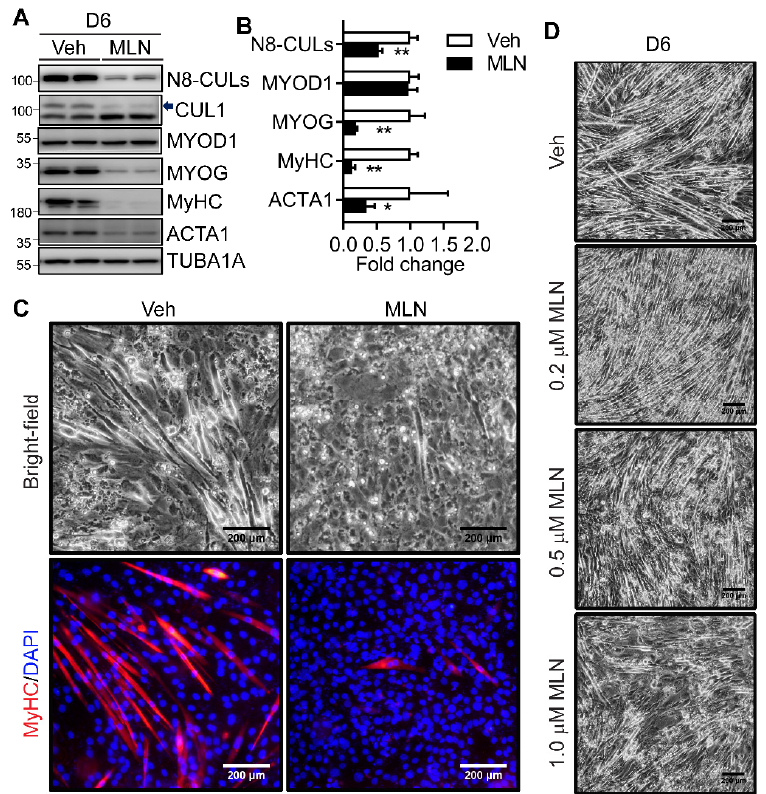
Figure 2. Neddylation inhibition mediated by a specific NAE1 inhibitor MLN4924 blocks C2C12 myotube formation. ( A , B ) Western blot analysis of neddylated Cullins (N8-CULs), CUL1, and muscle differentiation markers in vehicle (Veh)-treated and MLN4924 (MLN, 0.5 µ M)-treated C2C12 for 6 days (D6) in differentiation media. Proteins were quantified and normalized to TUBA1A. Arrow indicates neddylated CUL1. Data were presented as fold changes with Veh-treated cells set at 1. * p < 0.05; ** p < 0.005 vs. Veh. Unpaired t tests. ( C ) Representative bright-field and immunofluorescence images of Veh-treated and MLN-treated C2C12 at D6 of differentiation. Cells were stained with MyHC (red), and nuclei were counterstained with DAPI (blue). Scale bar: 200 µ m. ( D ) Representative bright-field images of Veh- and MLN-treated C2C12 cells at D6 in differentiation media with insulin. MLN at indicated doses was only treated for the first 2 days of differentiation. Scale bar: 200 µ m. Three independent